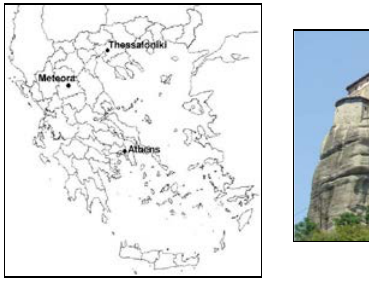
Figure 2. The Roussanou